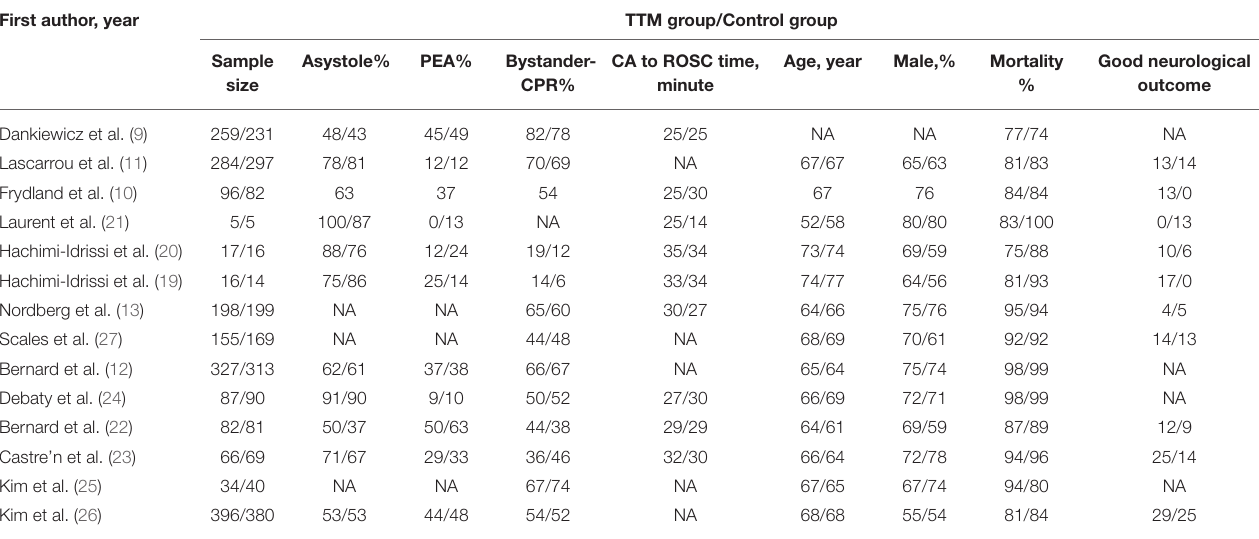
TABLE 2 | Characteristics of the patients included in current systemic review and